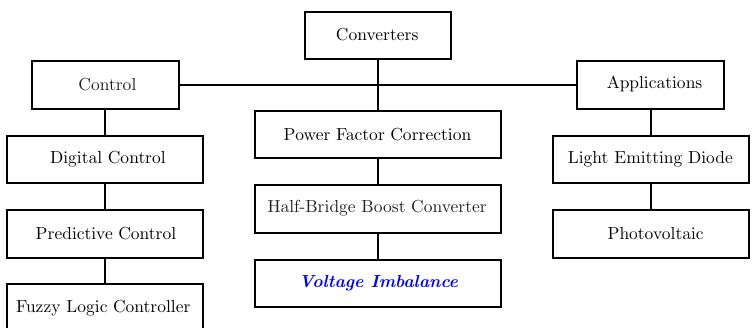
Figure 2. Graphic description of the related works.